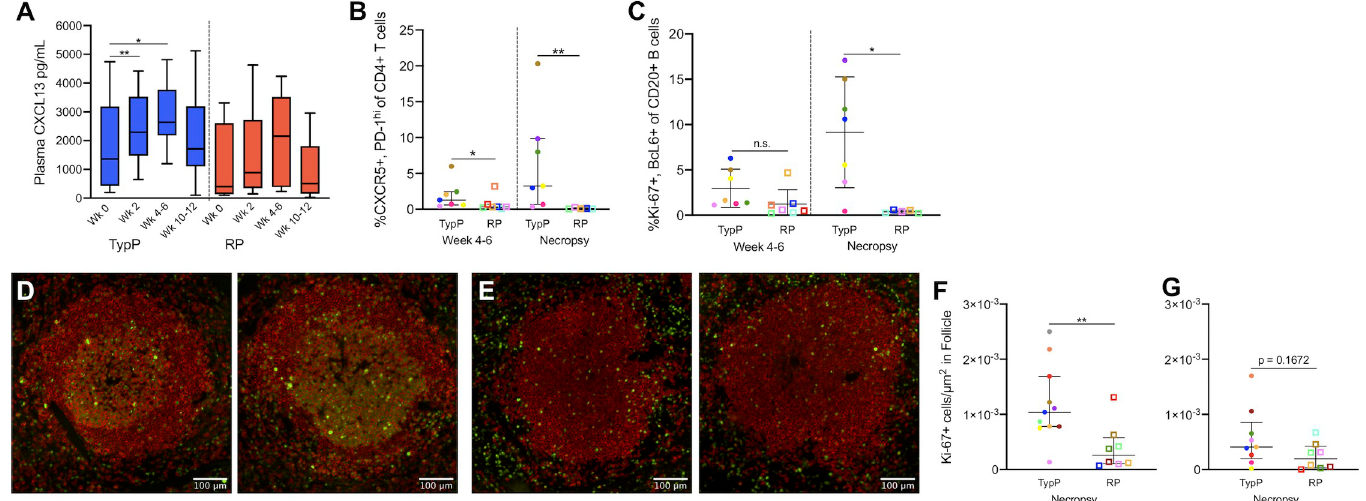
Fig 6. Rapidly progressing infants exhibit germinal center dysfunction in secondary lymphoid tissues. Plasma CXCL13 concentrations were measured at timepoints prior to and following SIV infection in TypP ( blue bars ) and RP ( red bars ) infants ( A) Levels of T follicular helper cells (CXCR5+, PD-1+)( B ) and germinal center B cells (Ki-67+, BcL6+)( C ) were measured in axillary lymph node biopsies from early chronic (4–6 weeks post-infection) and necropsy. Paraffin embedded spleens from RP and TypP infants were sectioned and immuno-stained for B cells (CD20, red) proliferation (Ki-67, green) to identify splenic B cell follicles and germinal centers. Representative images are shown for TypP infants ( D ) and RP infants ( E ). Whole sections were scanned and stitched, and Ki-67 positive foci were quantified in B cell follicles of spleen ( F ) and axillary lymph node ( G ). Statistical tests used to compare infant groups were carried out as described in the methods �� = p < 0.01. Error bars are shown as either mean with standard deviation or median with interquartile range based on data